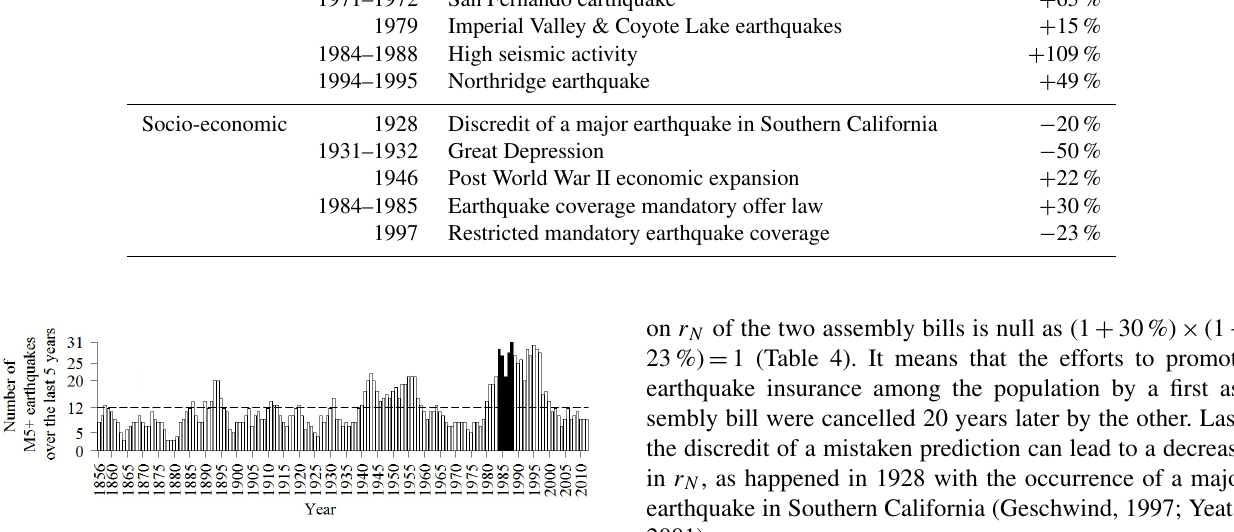
Figure 7. Number of earthquakes with a moment magnitude M5 + occurring during the 5 previous years. For year N , the sum is calcu- lated from N − 5 to N − 1. Earthquakes occurring the same day count as one. Black bars correspond to the peak of seismicity observed be- tween 1984 and 1988. The dotted line represents the average value from 1855 to 2012. The historical earthquake database used is taken from the UCERF3 (Field et al., 2013; Felzer,